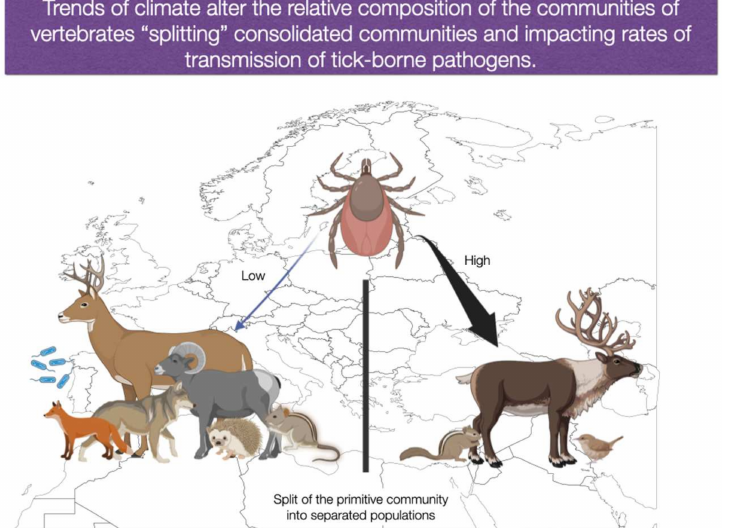
Figure 5. Climate is an essential driver of the reservoir composition of tick-borne pathogens.The situation schematized in Figure 4 is subjected to change because the climate could segregate estab- lished communities of vertebrates. Such split of communities could be the outcome of the different tolerance to the climate of the species of vertebrates involved. The split would contribute to changes in the epidemiology of tick-borne pathogens because competent reservoirs could change its density in the newly established communities. The relative abundance of competent reservoirs and contact rates with the tick vector would be different for each group of vertebrates in the new environmental gradient, resulting in new epidemiological patterns. Parts of the illustration were created with BioRender.com (accessed on 1 November